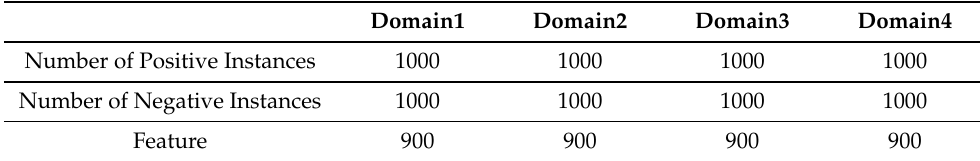
Table 1. Details of the ImageNet dataset used in our experiment. Domain1 Domain2 Domain3